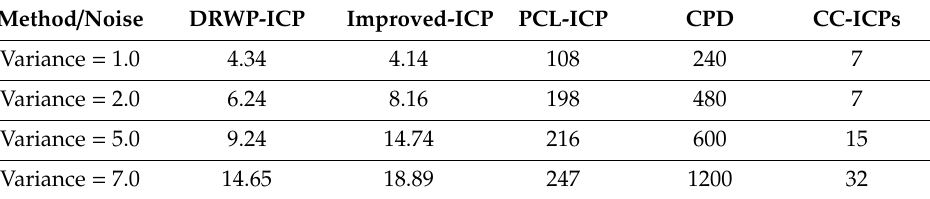
Table 11. Alignment times